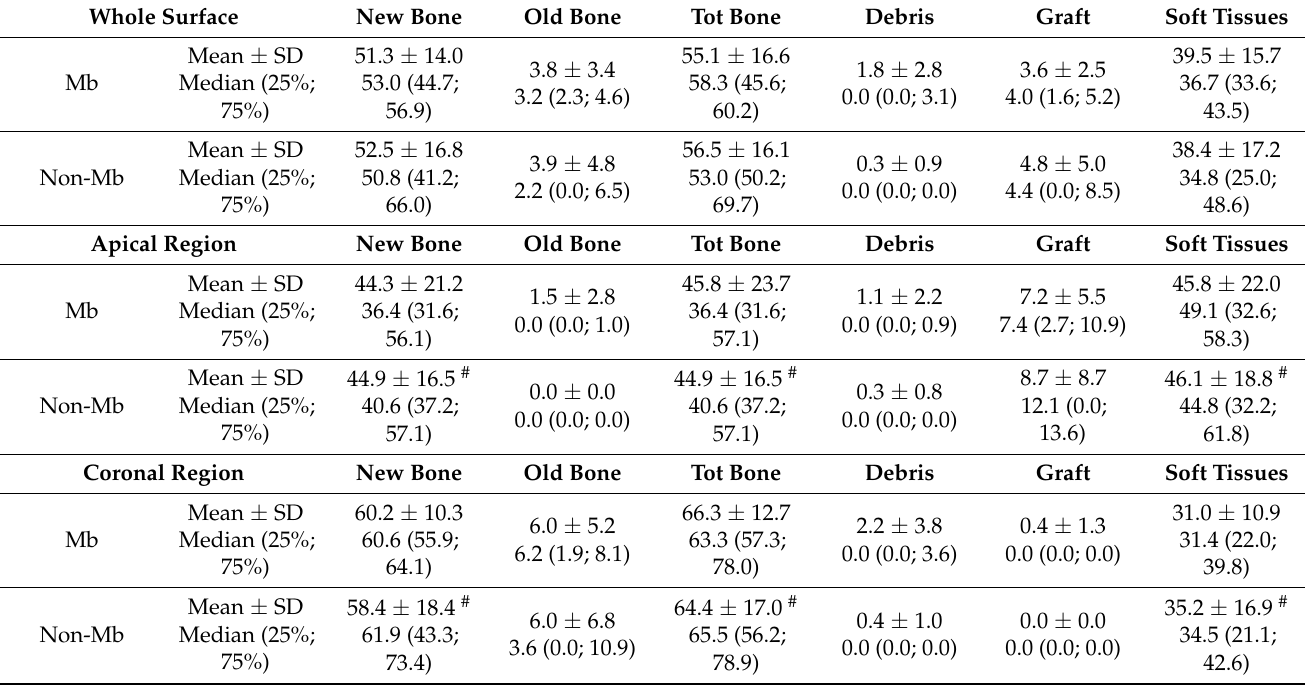
Table 2. Membrane group (Mb, n = 8) and non-membrane group (non-Mb, n = 7). Tissues in contact with the implant surface expressed in percentages (%) for the whole implant surface and for the apical and coronal regions of the implant. SD, standard deviation; 25%, first percentile; 75%, third percentile; # = p < 0.05 between apical and coronal